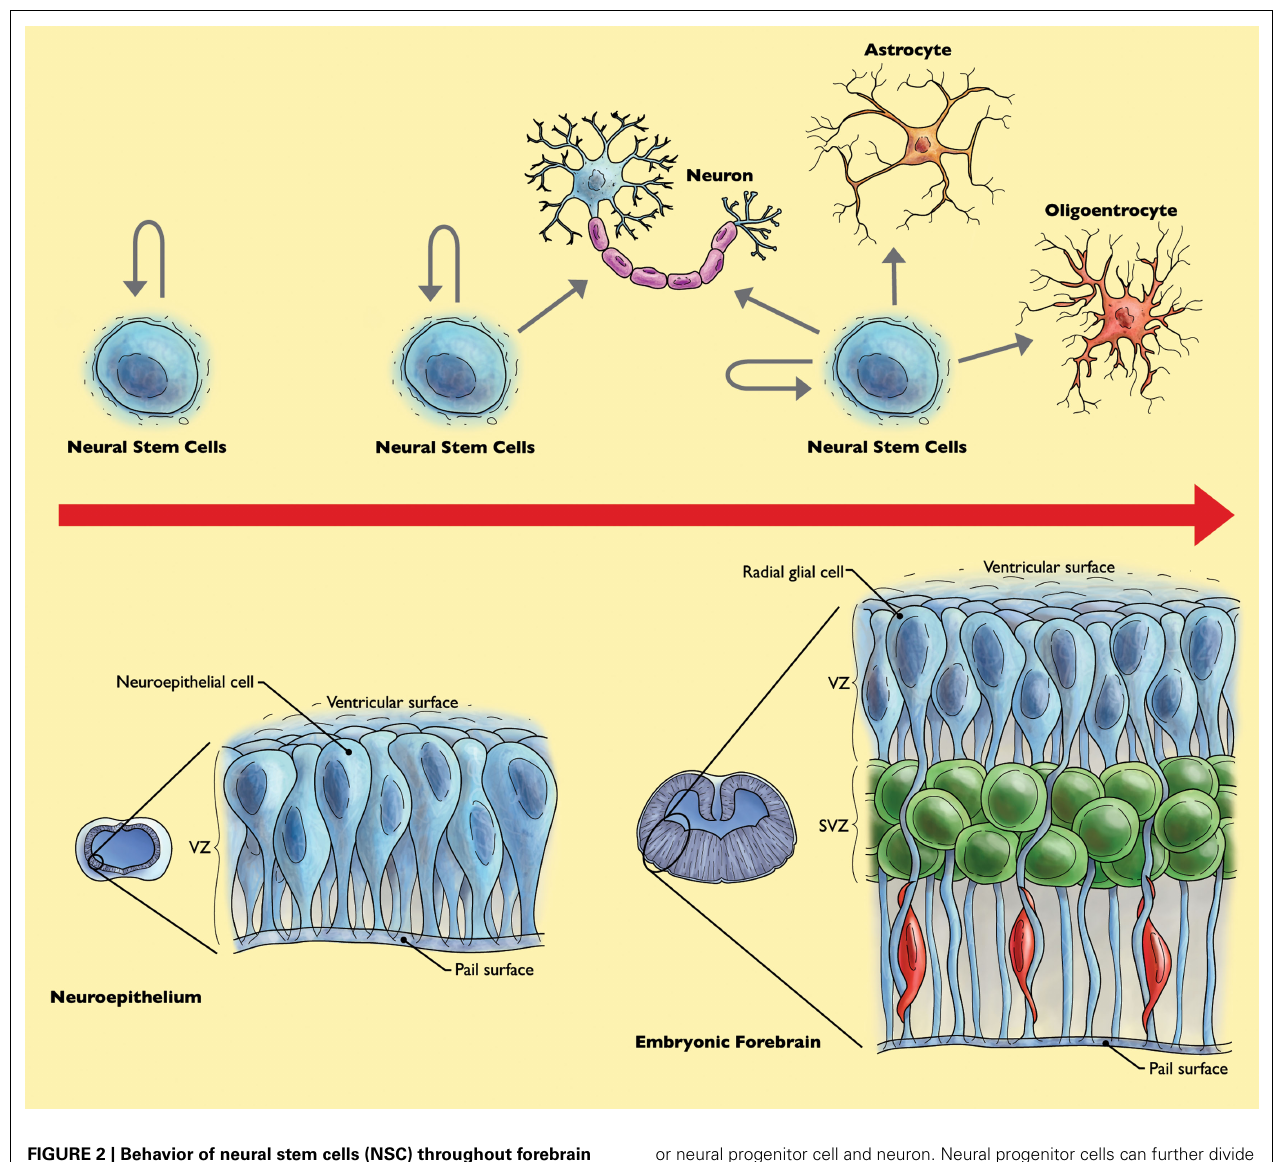
FIGURE 2 | Behavior of neural stem cells (NSC) throughout forebrain development. Early during development, NSC increase their population of stem cells through symmetrical cell divisions. At mid-gestation, at the “neurogenic phase,” NSC divide asymmetrically, yielding a NSC and a neuron